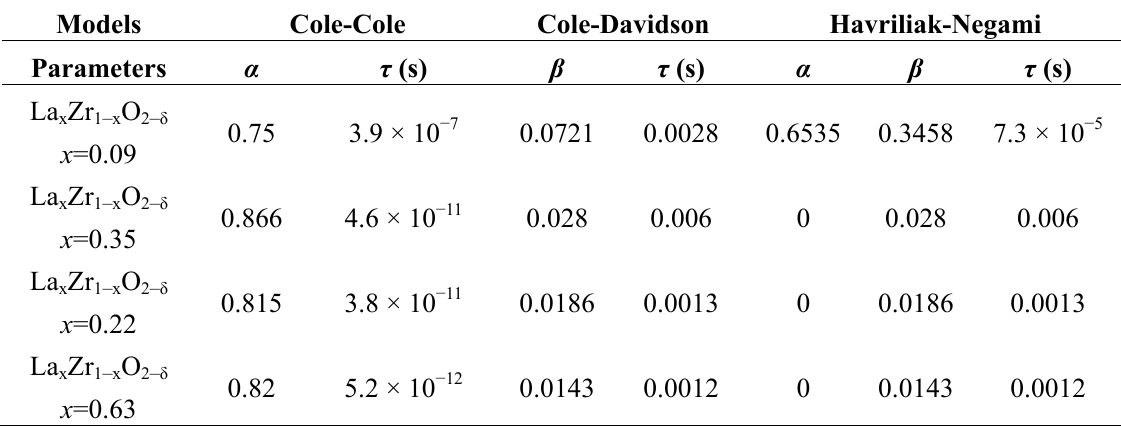
Table 1. The fitted parameters of the dielectric relaxation models for Figure 16. Models Cole-Cole Cole-Davidson Parameters